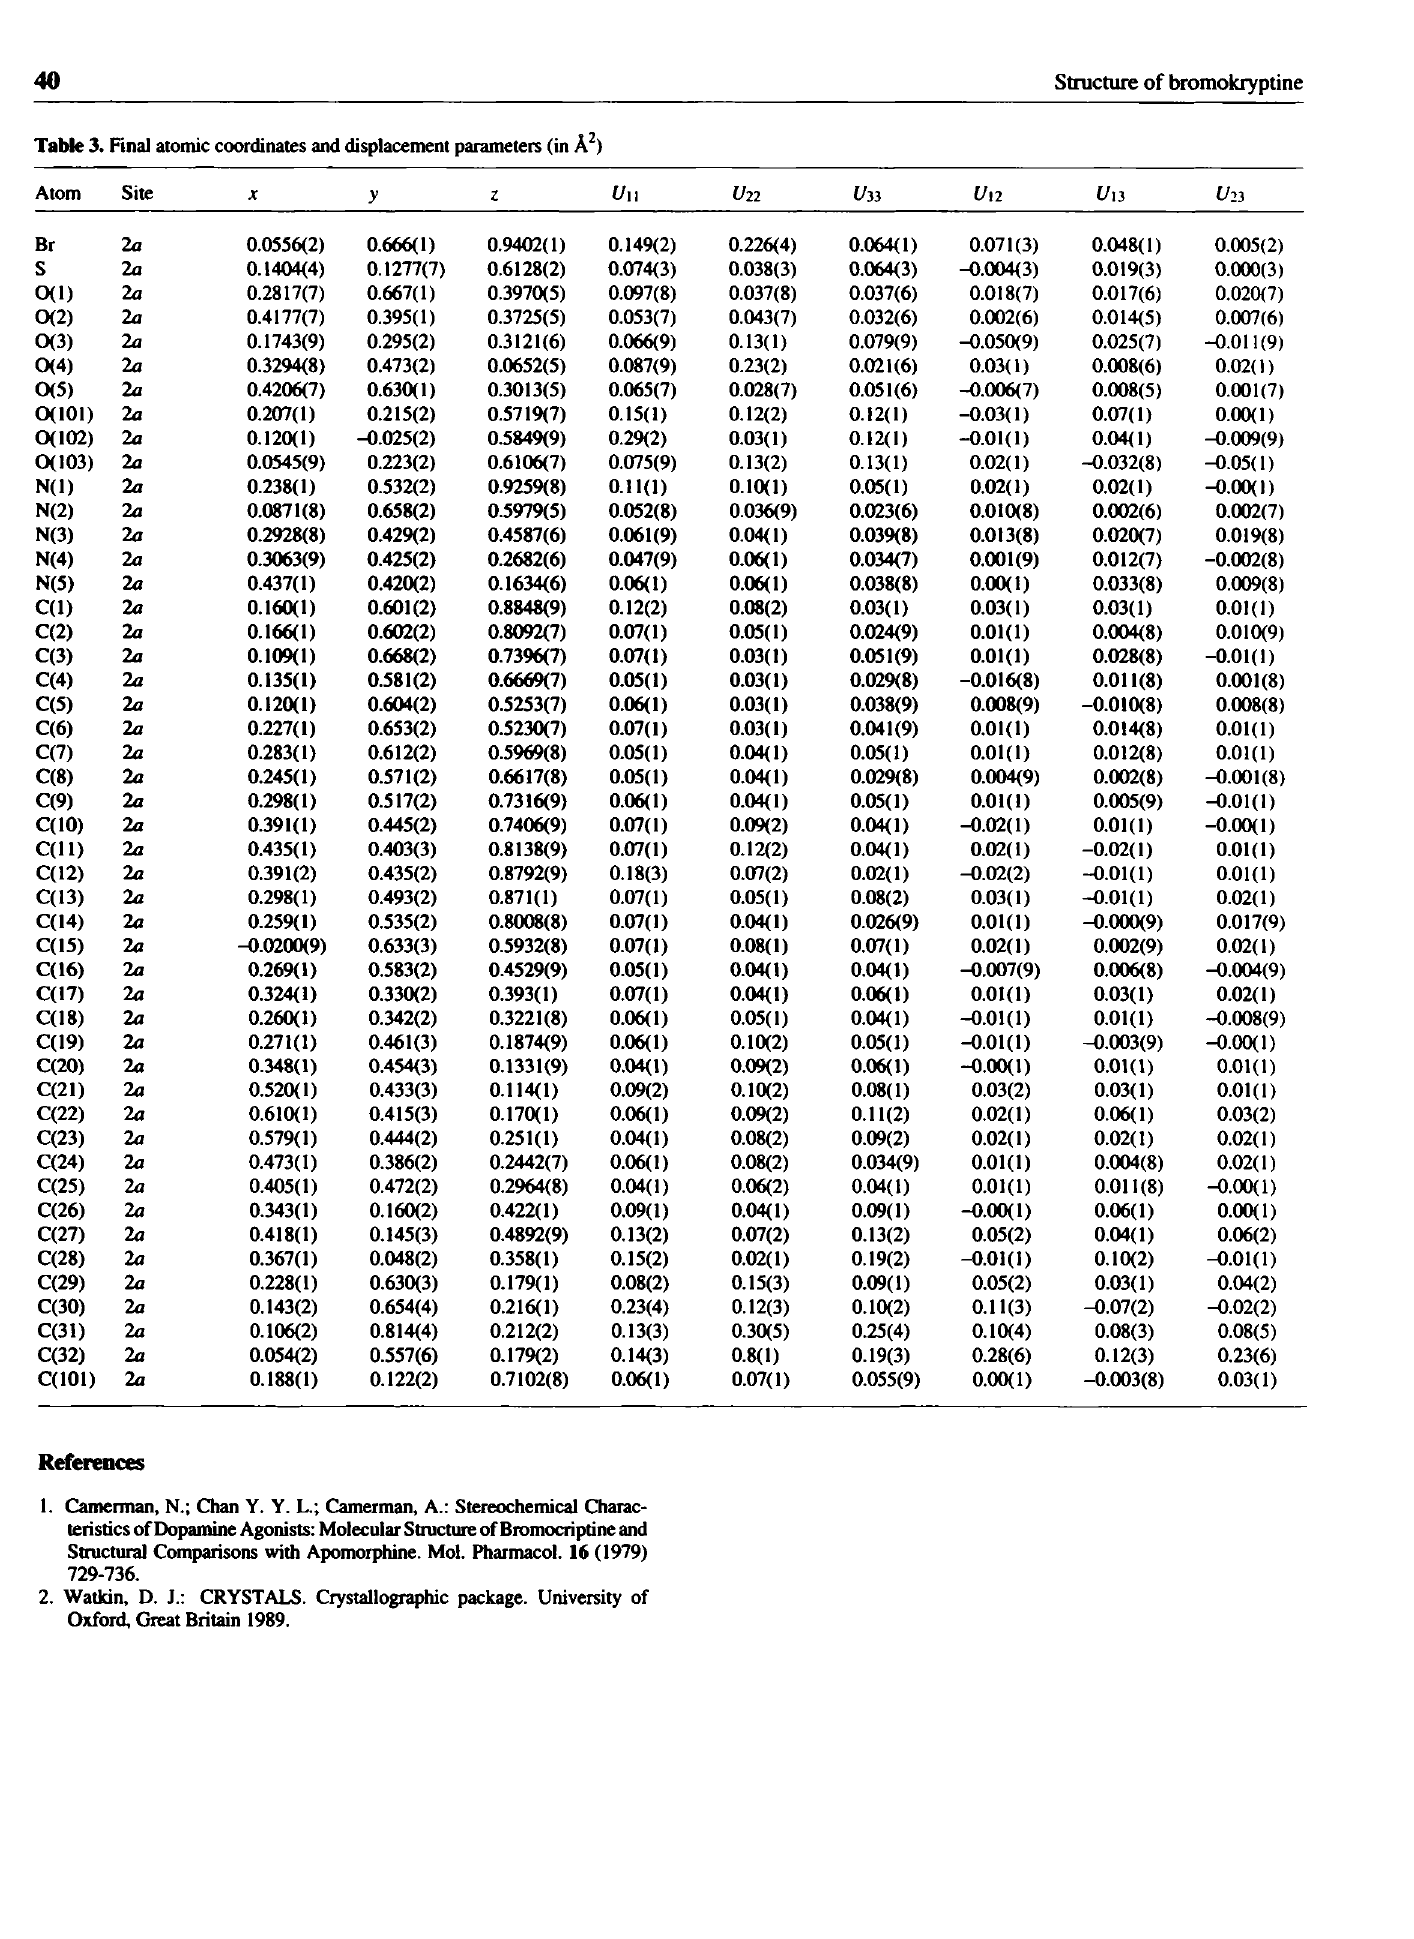
Table 3. Final atomic coordinates and displacement parameters (in Â 2